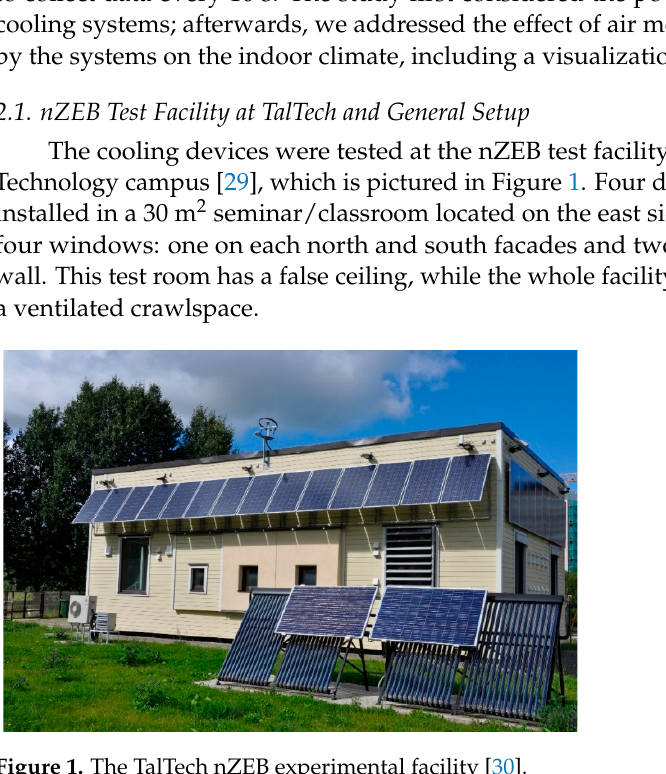
Figure 1. The TalTech nZEB experimental facility [30].